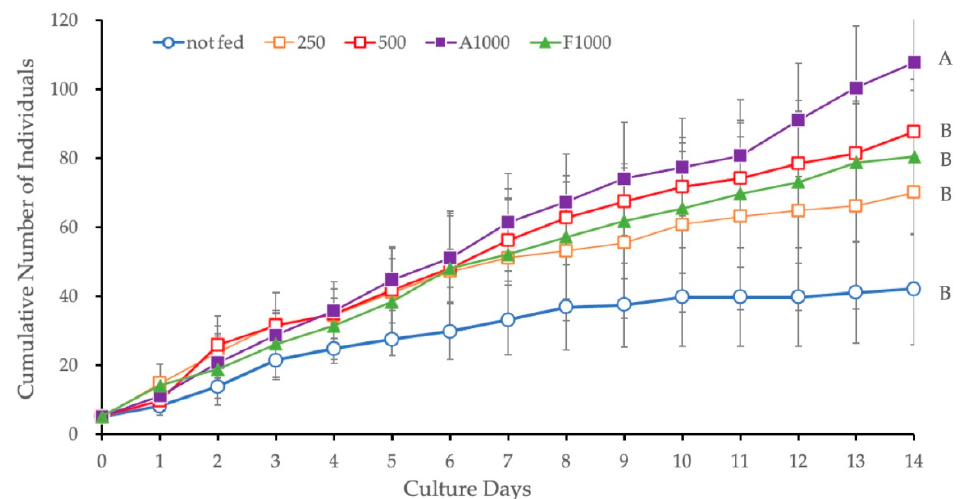
Figure 7. Population growth of A. minuta fed different diet treatments over a 14-day culture period. Data are expressed as means ± SD; each of the diet treatments started with five anemones at day 0. Letters beside the 14th day of the dotted line graph denote significant differences in relation to different diet treatments ( p < 0.05, n = 3, A > B). Abbreviations: unfed, control; 250, 250 individuals/day of Artemia salina ; 500, 500 individuals/day of A. salina ; A1000, 1000 individuals/day of A. salina , and F1000, 1000 individuals/day of Fistulobalanus kondakovi.